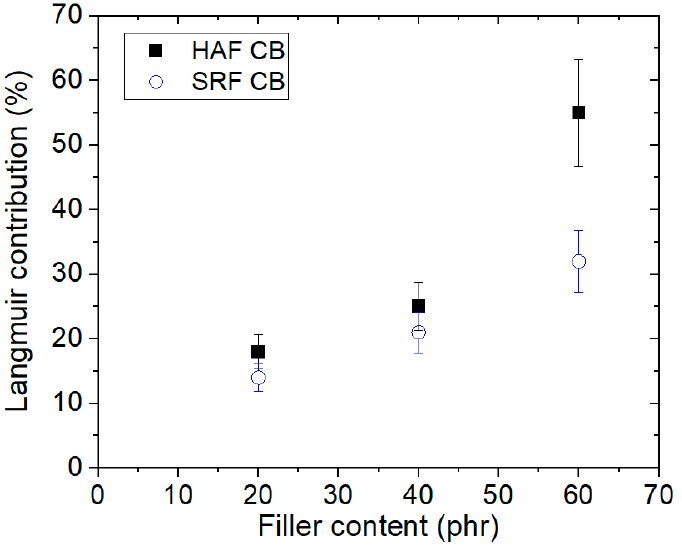
Figure 6. Langmuir contribution versus filler content for CB-filled EPDM